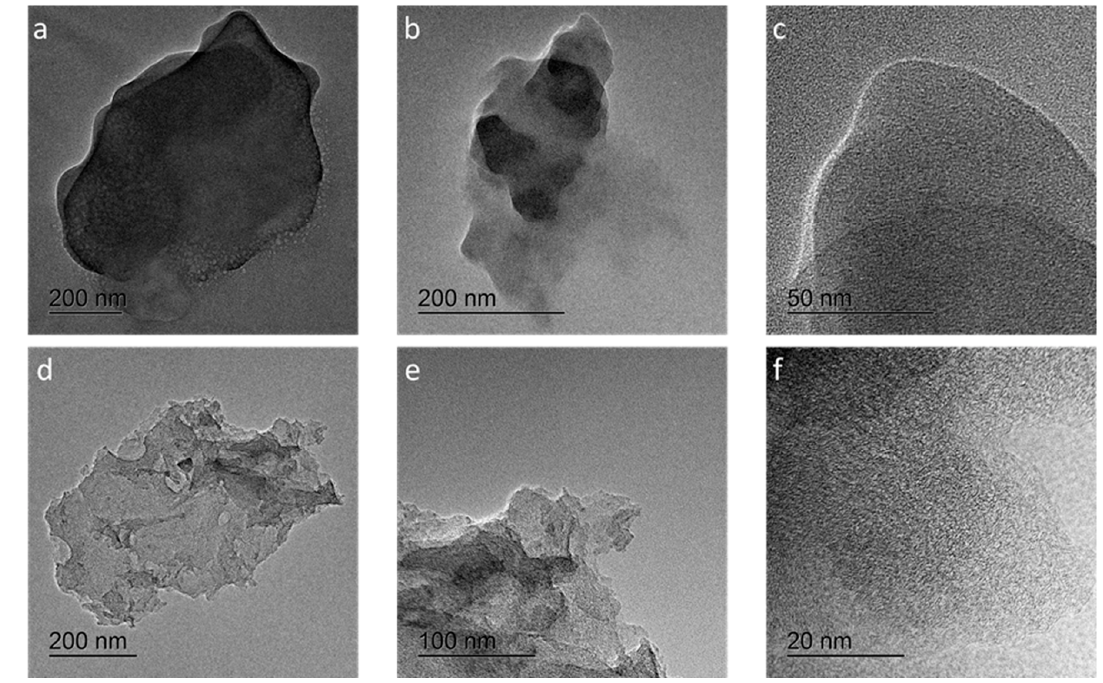
Figure 3. TEM images of ( a ) coffee sludge (CS), ( b,c ) non-activated hydrochar (HC), and ( d – f ) activated hydrochar (AHC). High-resolution TEM images of individual AHC showing torn porous structure and rough graphitic structure.